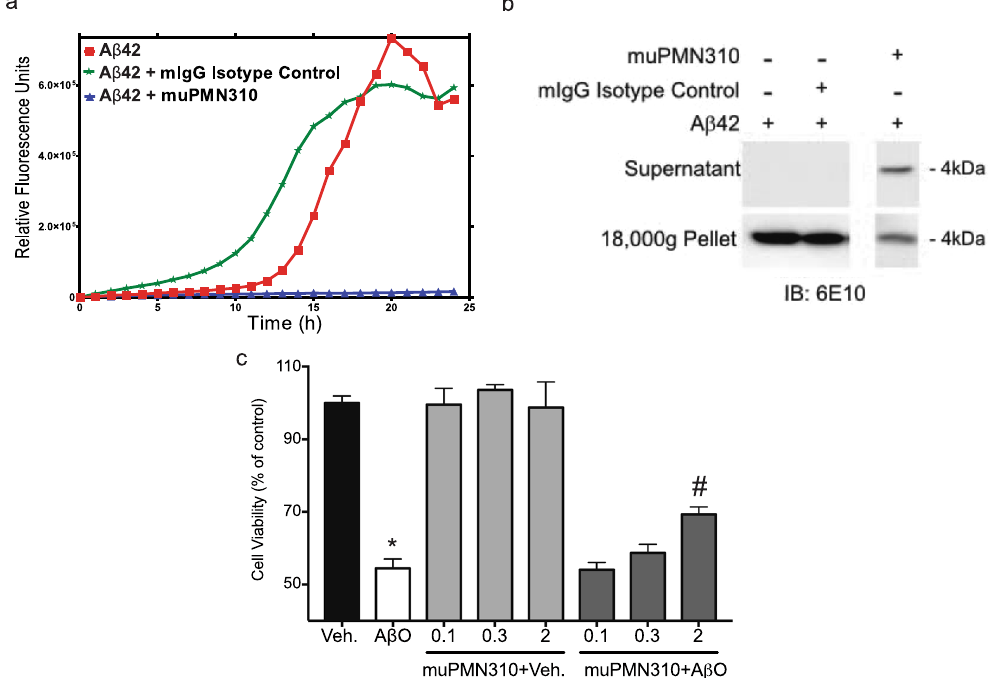
Figure 4. muPMN310 binding inhibits A β 42 aggregation and A β 42O toxicity in vitro . ( a ) β -sheet formation was tracked for 24 hours in vitro with a Thioflavin T fluorescent assay after addition of A β monomers alone (red line), or in the presence of muPMN310 (blue line) or isotype control mIgG (green line) at a molar ratio of 1:5 (Antibody:A β ). Data are representative of three independent experiments. ( b ) Thioflavin T fluorescent assay samples were collected at end-point and fractionated into soluble A β (Supernatant; monomers, small oligomers) or insoluble A β (Pellet; large aggregates) by centrifugation, then run on a denaturing SDS-PAGE gel for monomerization and immunoblotting with pan-A β antibody, 6E10. Shown are representative data from one of two identical experiments. ( c ) MTT assay of viability of neurons treated with vehicle (Veh.) or A β O and increasing molar ratios of muPMN310. Antibody:A β O ratios of 1:10 (0.1), 1:3 (0.3), 2:1 (2). Mean ± SEM shown. Differences were determined with a Students t-test: ( * ) Veh. vs A β O p ≤ 0.0001, (#) A β O vs muPMN310 + A β O p = 0.0112. Similar results were observed in 3 independent